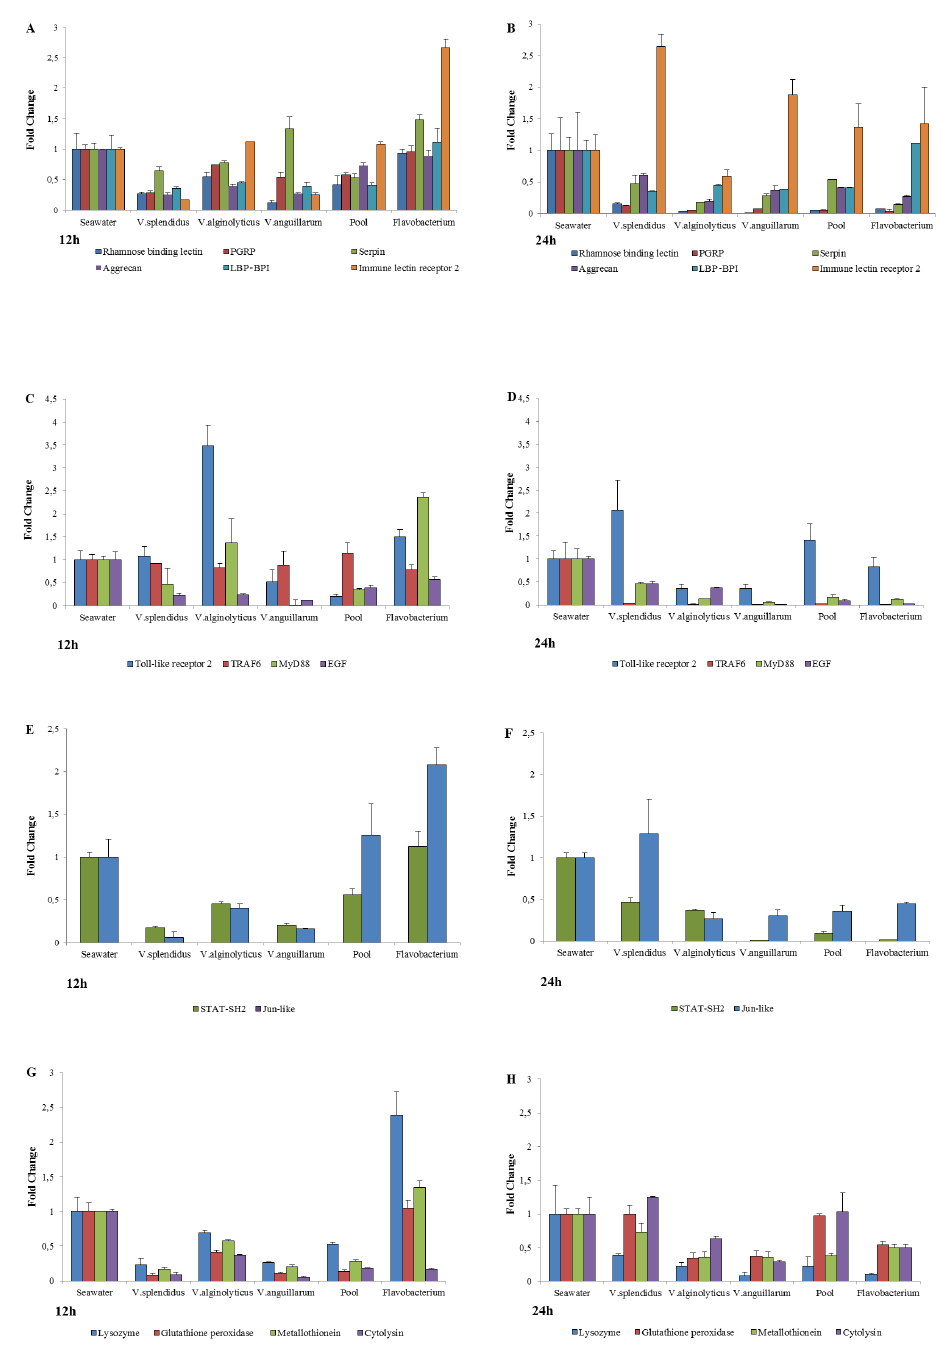
Fig. 1. Differential expression of immune genes. (A) Expression levels of immune recognition genes (Rhamnose-binding lectin, PGRP, Serpin, Aggrecan, LBP-BPI and Immune lectin receptor 2) from B. azoricus infected gills at 12h infection time. (B) Expression levels of immune recognition genes as in (A) , from B. azoricus infected gills at 24h infection time. (C) Expression levels of immune signaling genes (Toll-like receptor 2, TRAF6, MyD88 and EGF) from B. azoricus infected gills at 12h infection time. (D) Expression levels of immune signaling genes as in (C) , at 24h infection time. (E) Expression levels of immune transcription genes (STAT-SH2 and Jun-like) from B. azoricus infected gills at 12h infection time. (F) Expression levels of immune transcription genes as in (E) , at 24h infection time. (G) Expression levels of immune effector genes (Lysozyme, Glutathione peroxidase, Metallothionein and Cytolysin) from B. azoricus infected gills at 12h infection time. (H) Expression levels of immune effector genes as in (G) , at 24h infection time. Data expressed as Means and Standard Deviation with two technique replicates. Bars represent the level expression (Fold change) of target gene, in different experimental conditions, and normalised to the housekeeping gene